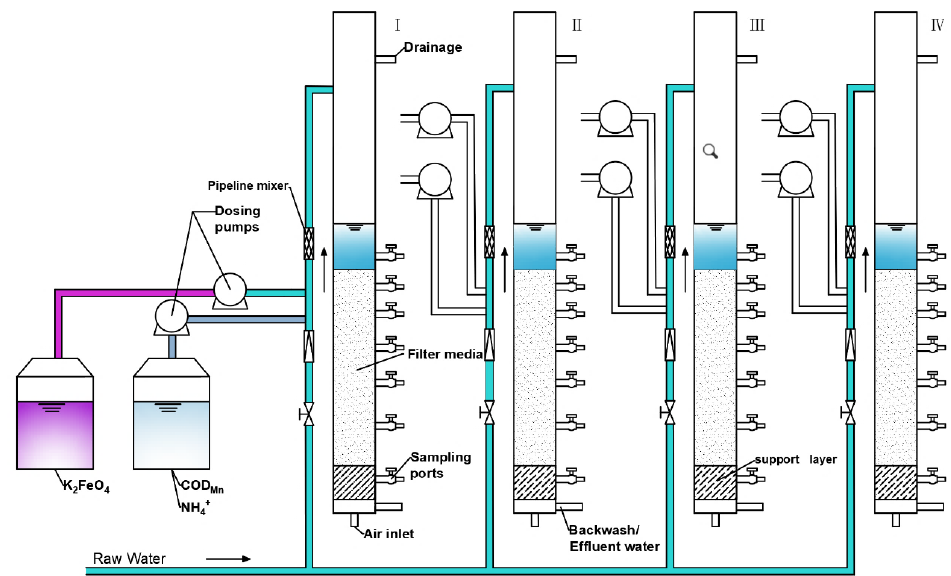
Figure 1. Schematic diagram of the pilot filter system.